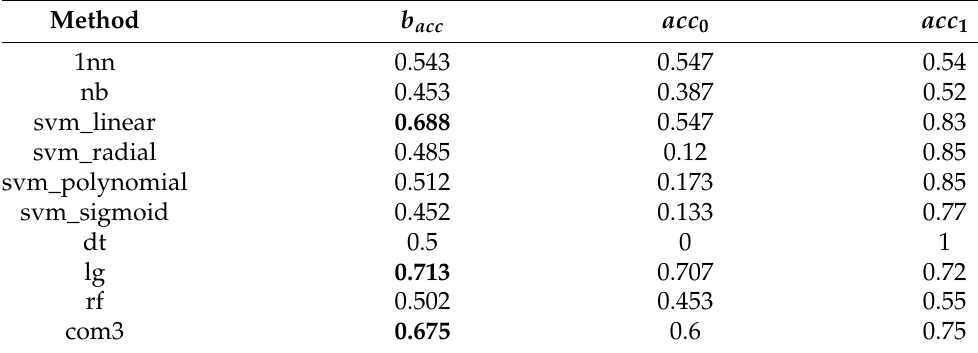
Table 7. Summary of results for data.bee1.3 with baseline correction.